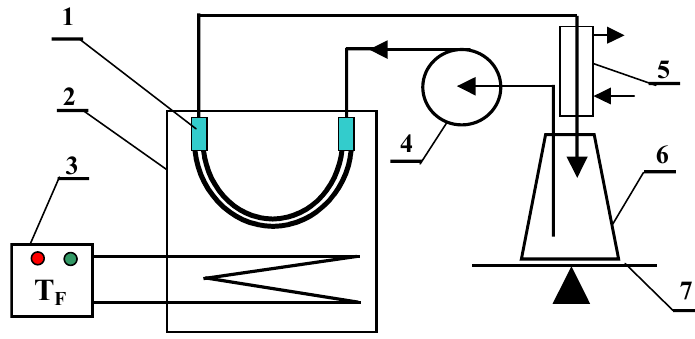
Figure 1. MD experimental set-up. 1—MD module, 2—feed tank, 3—Nűga temperature regulator, 4—peristaltic pump, 5—cooler, 6—distillate tank, 7—balance.